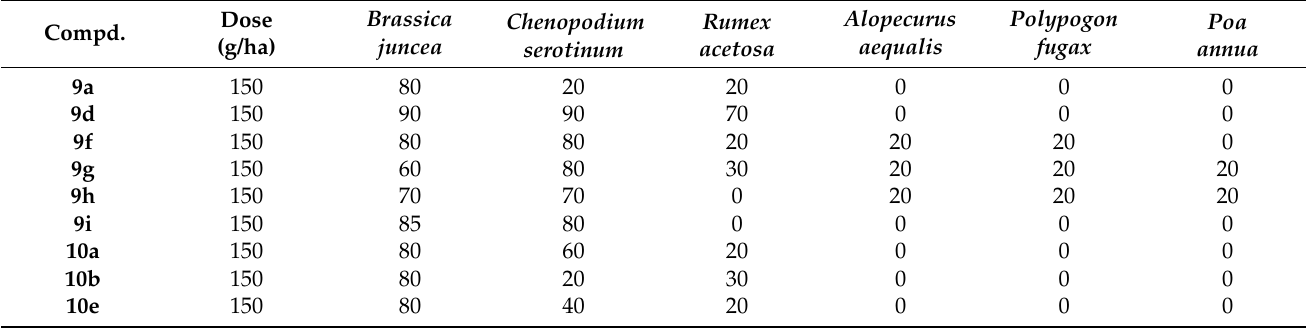
Table 2. Herbicidal activity (inhibition rate, %) of some compounds at 150 g/ha.